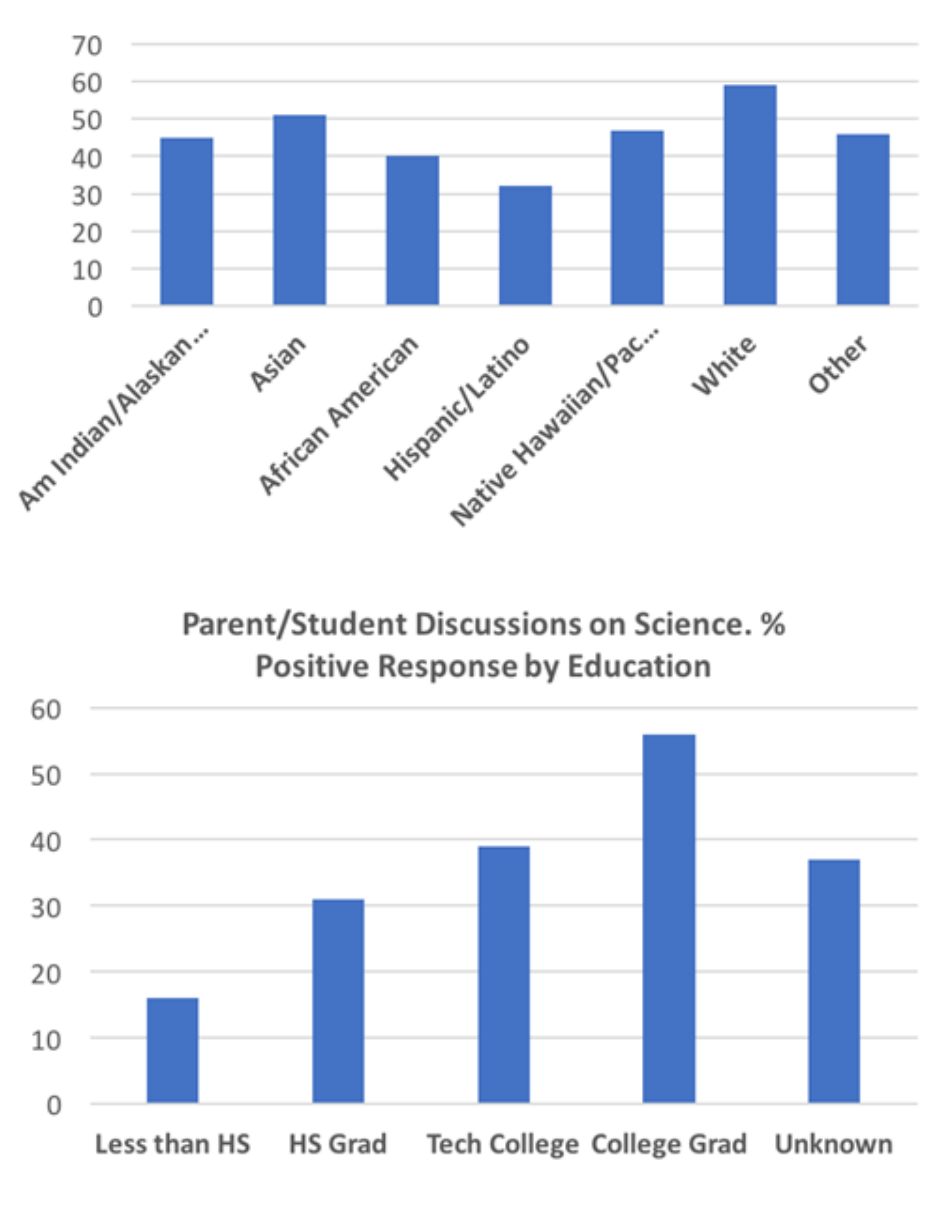
Figure 5. Parent involvement in science discussion in